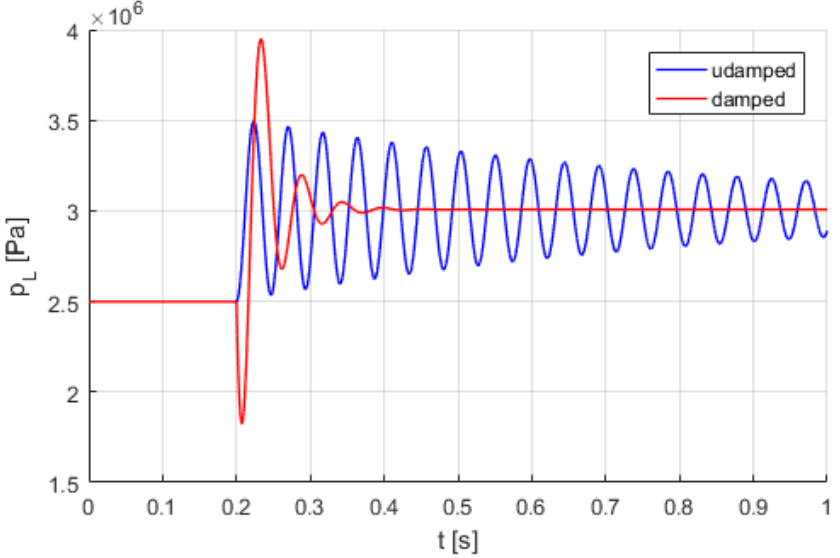
Figure 13. Comparison of the dynamic responses of the undamped and damped shock pressure p L ( t )